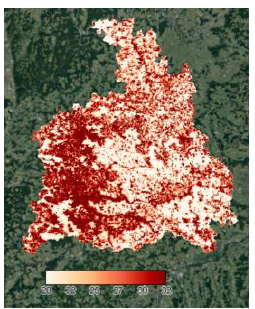
Figure 8: LST Stuttgart - Spring.